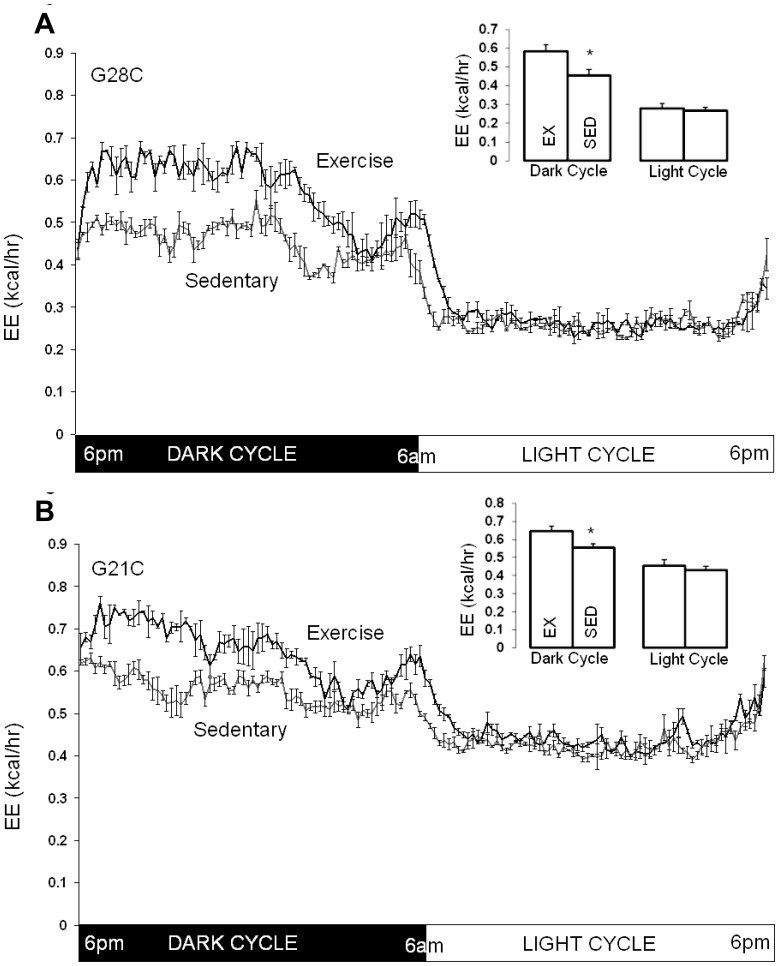
Effect of exercise cessation on total energy expenditure (EE) in G28C and G21C groups.A. G28C group (n = 8) housed at 28°C. Mean EE (kcal/hr) rate every 10 min during the entire photoperiod with Exercise and after running wheels were locked (Sedentary). Insert: Cumulative mean dark cycle and light cycle EE in G28C mice during the Exercise period (EX) and after running wheels were locked (SED). B. G21C group (n = 8) housed at 21°C. Mean EE (kcal/hr) rate every 10 min during the entire photoperiod with Exercise and after running wheels were locked (Sedentary). Insert: Cumulative mean dark cycle and light cycle EE in G21C mice during the Exercise period (EX) and after running wheels were locked (SED). All data shown as means ± SEM for 3(EX) or 4(SED) consecutive days, * signifies p<0.05 by pair-wise t-test.